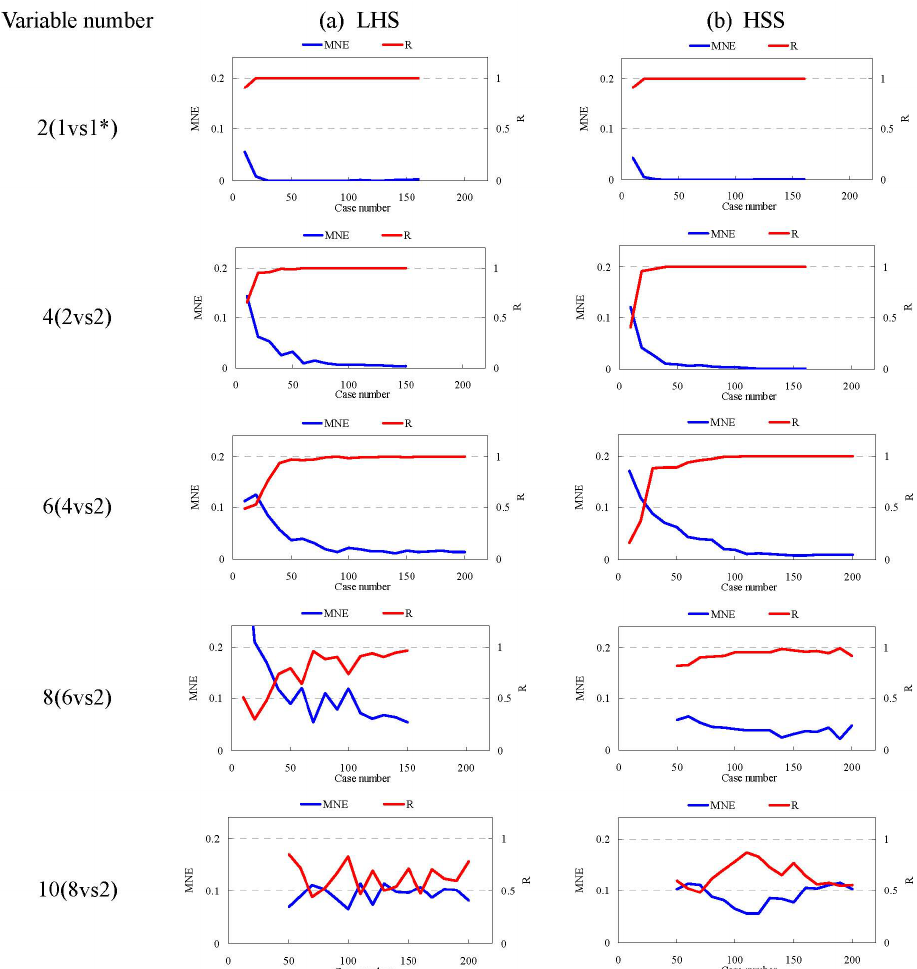
Fig. 7. Sensitivity of prediction performances to sample number and variable numbers through computational experiments (*1 vs. 1 means 1 type of NO x emission source and 1 type of VOC emission